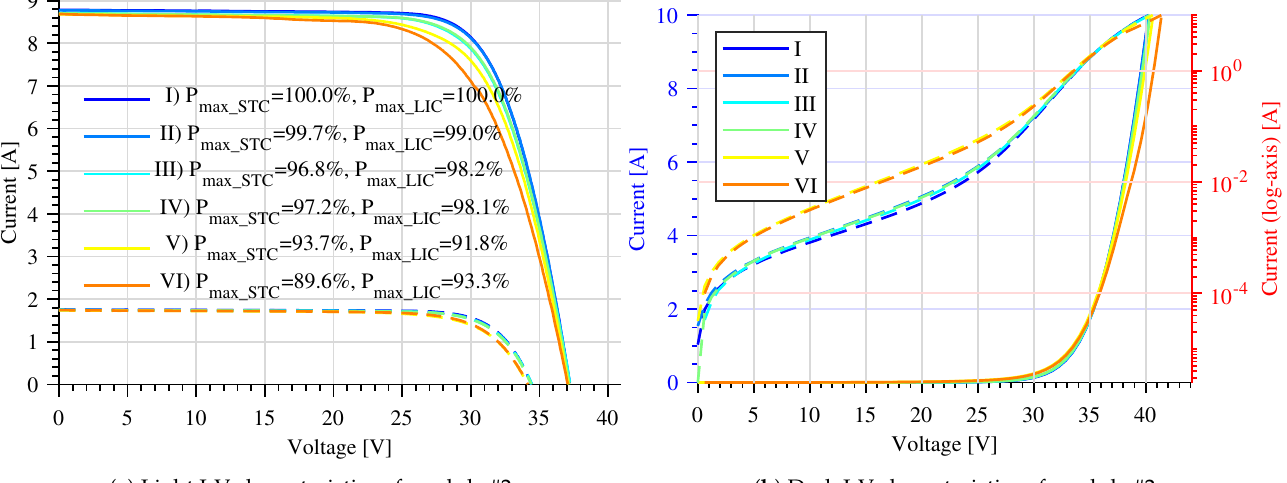
Figure A4. Electrical characteristics and relative maximum power loss of module #2 measured during the accelerated stress test: ( a ) light I-V characteristics measured at STC and low irradiance conditions (LIC, 200 W/m 2 ); ( b ) dark I-V characteristics of module #2 measured at 25